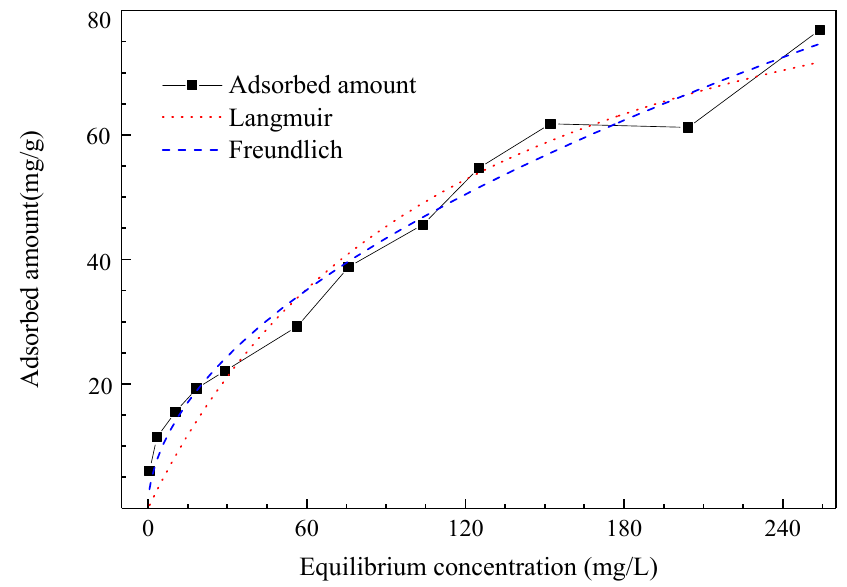
Figure 4. Adsorption isotherms of the modified peat with the Langmuir (red) and Freundlich (blue) models.